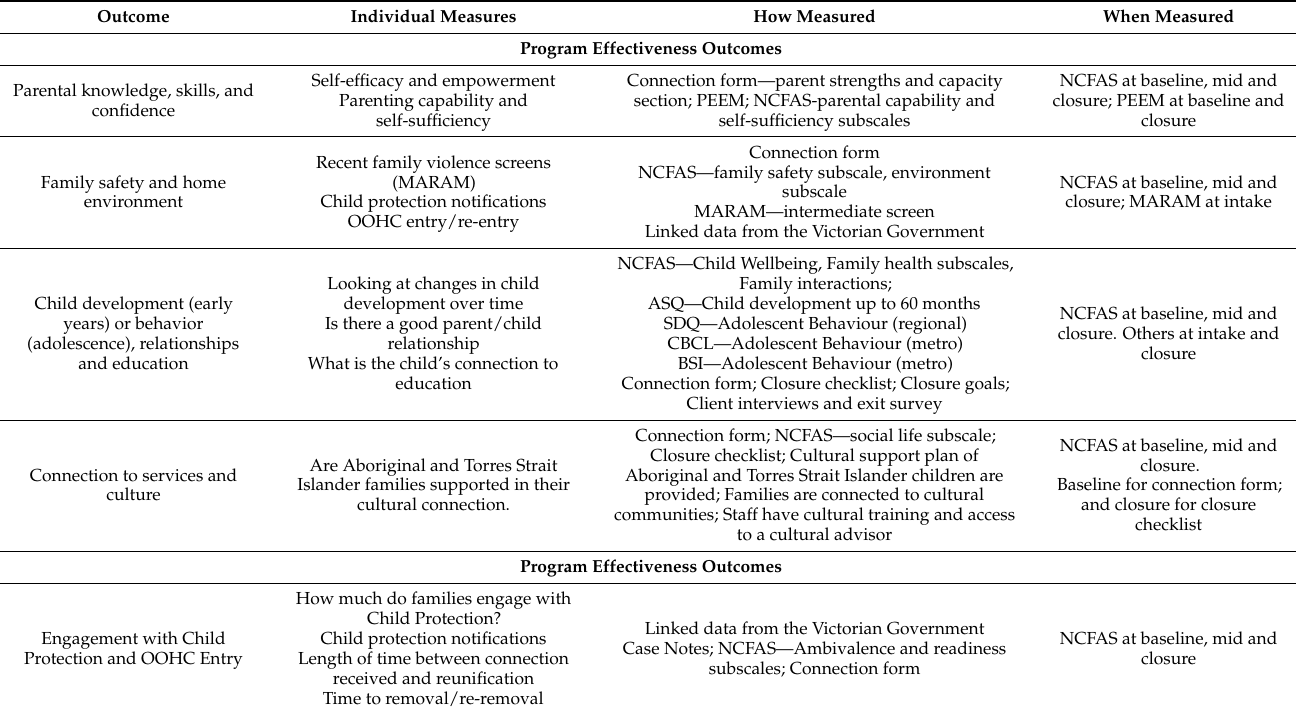
Figure 1. Outcomes and measures to evaluate the effectiveness and implementation of FPR. Note. NCFAS = North Carolina Family Assessment Scale; PEEM = Parent Efficacy and Empowerment Measure; MARAM = Family Violence Multi-Agency Risk Assessment and Management Framework; ASQ = Ages and Stages Questionnaire; SDQ = Strengths and Difficulties Questionnaire; CBCL = Child Behaviour Check List; BSI = Brief Symptom Inventory. Table 1. Effectiveness and implementation outcome